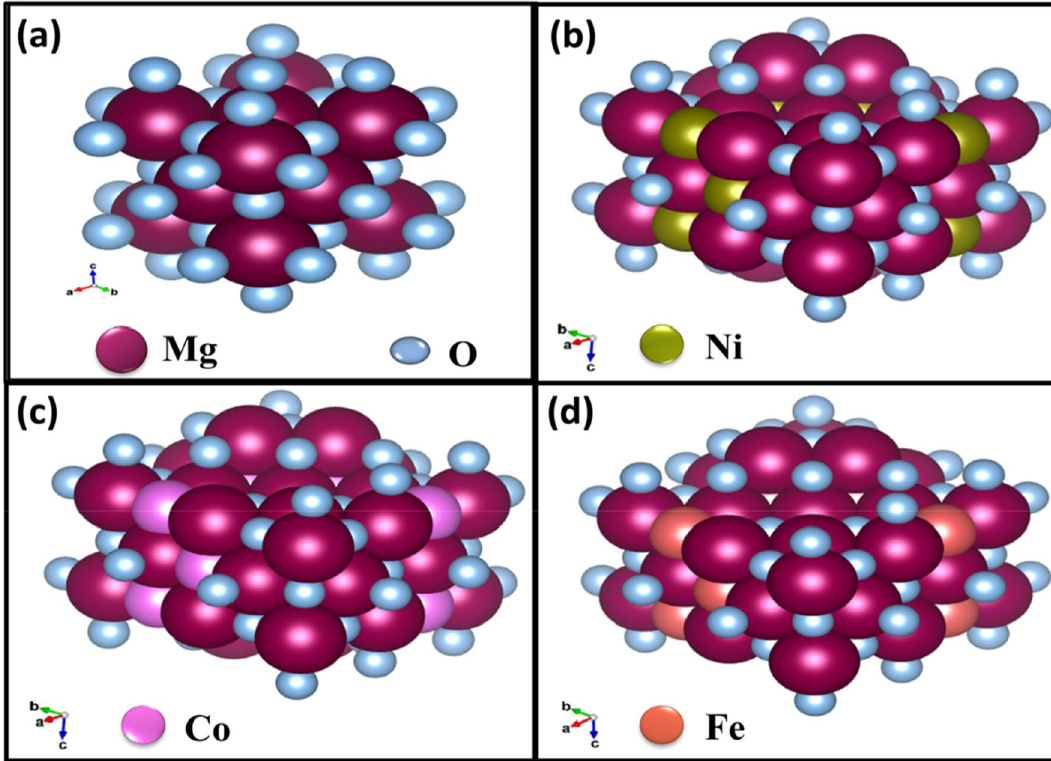
Figure 3. Cubic structure of ( a ) MgO, ( b ) Ni-doped MgO, ( c ) Co-doped MgO, ( d ) Fe-doped MgO